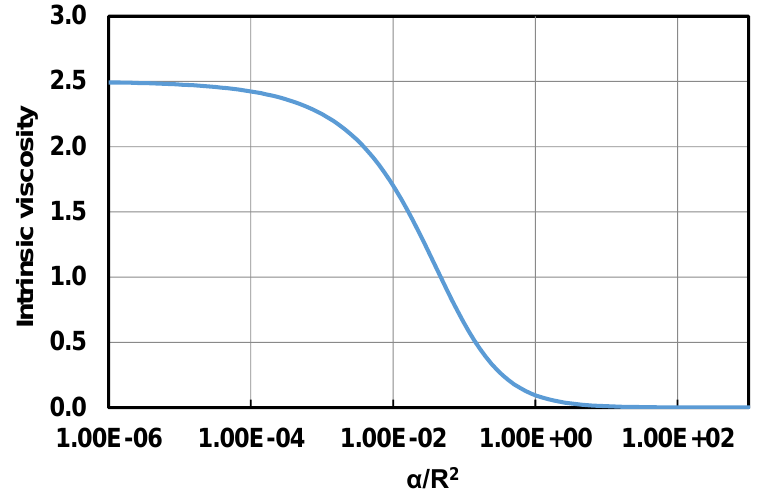
Figure 11. Intrinsic viscosity [ η ] as a function of dimensionless permeability ( α / R 2